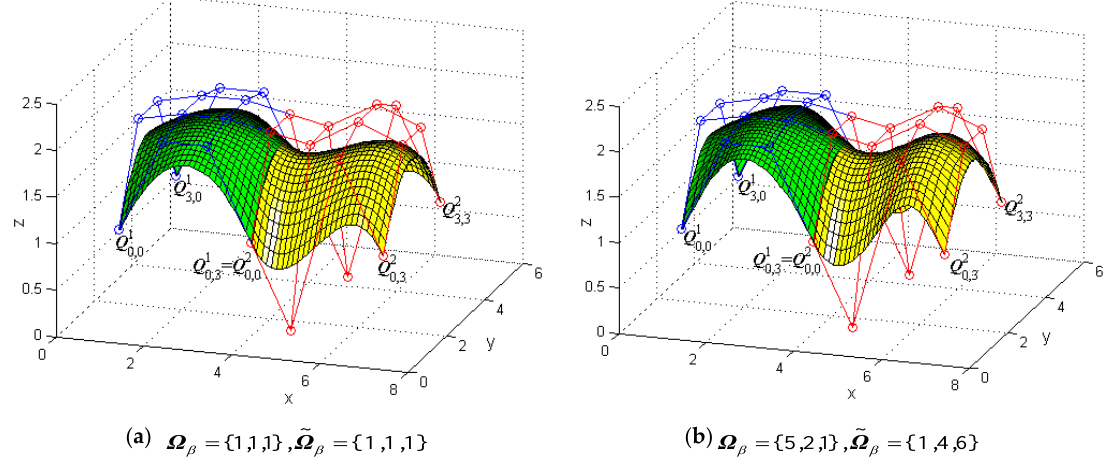
Figure 8. Generalized bicubic H-Bézier surfaces with G 1 continuity in the u direction.